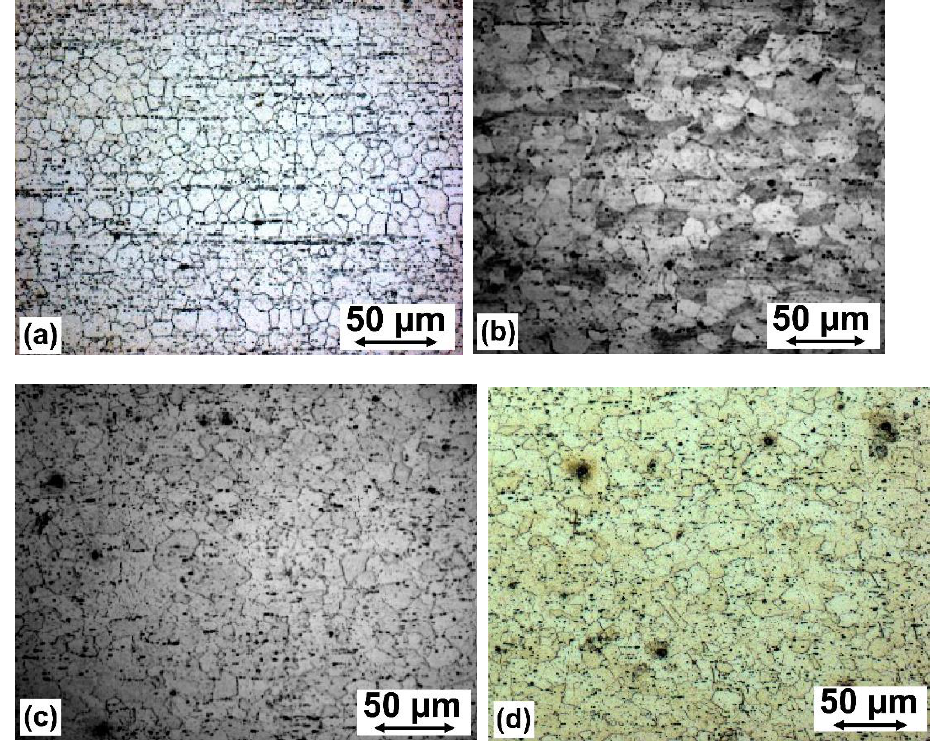
Figure 8. A typical microstructure of the hot-deformed material; as extruded ( a ) and extruded and hot-drawn for the temperature distribution t350 ( b ), t400 ( c ), and t440 ( d ). Longitudinal sections of the wires. The plastic flow direction along the horizontal axis.